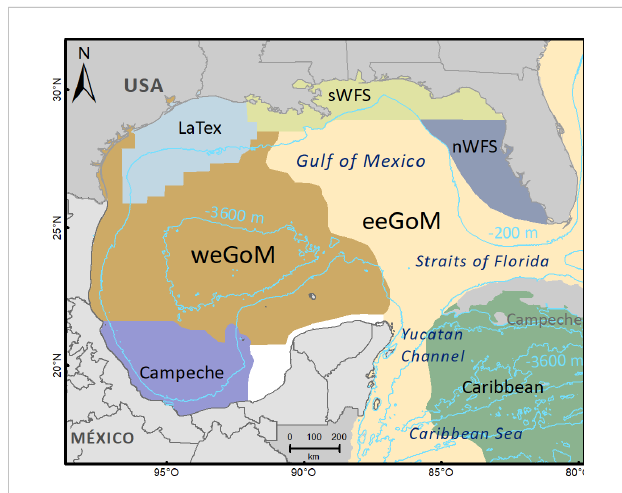
FIGURE 1 Scheme of oceanographic provinces in the Gulf of Mexico based on Miron et al.